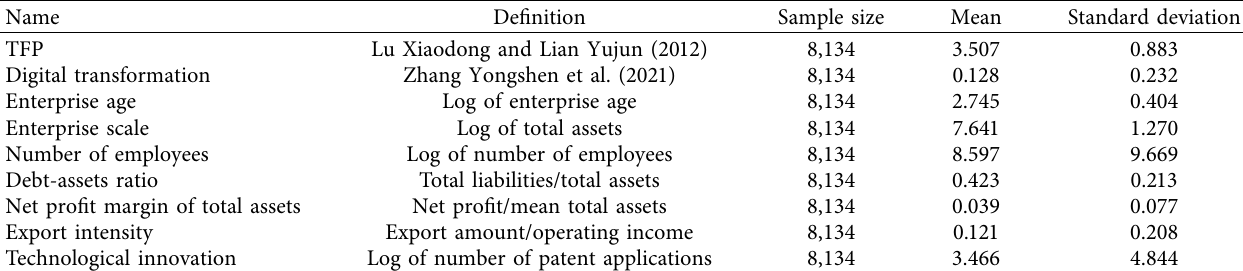
Table 1: Definition and descriptive statistics of variables.